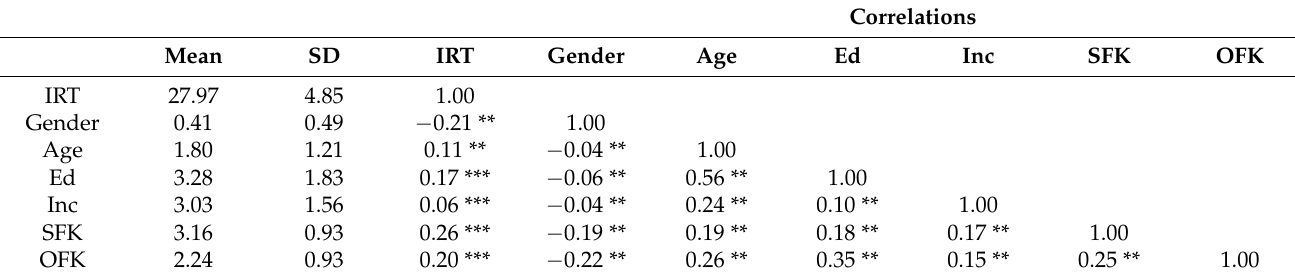
Table 1. Descriptive Sample Statistics (N =